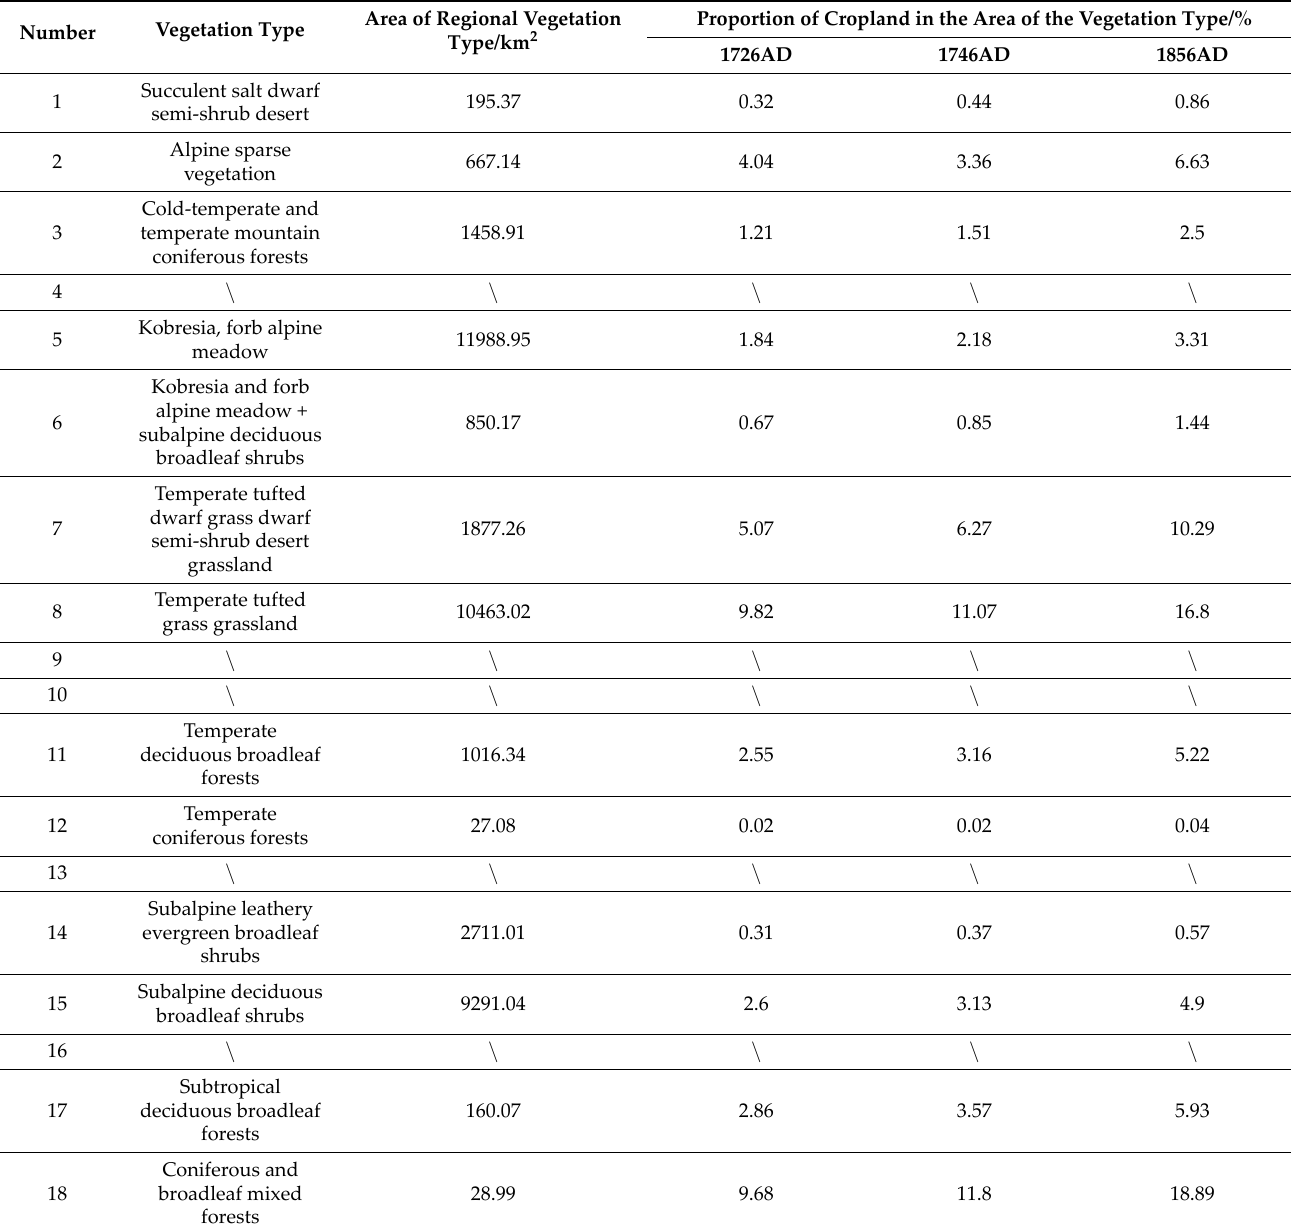
Table 4. Proportion of natural vegetation types reclaimed into cropland at three research time sec‑ tions during the Qing